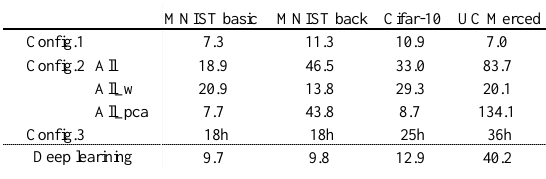
Table 3. Median of running time (sec/hour) per digit/category of the proposed methods and deep